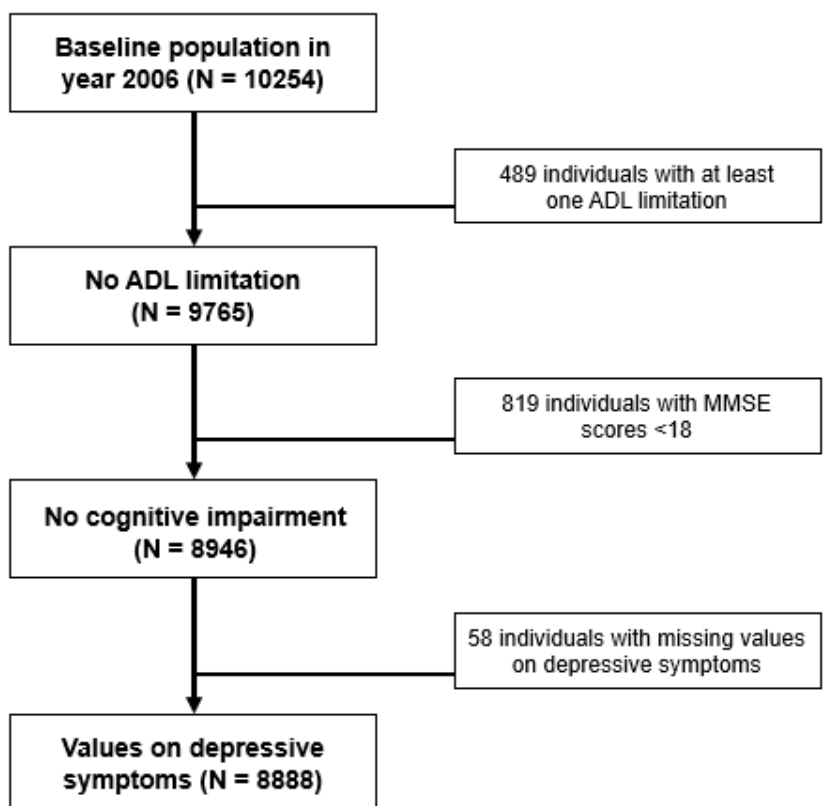
Figure 1. Study population selection process.